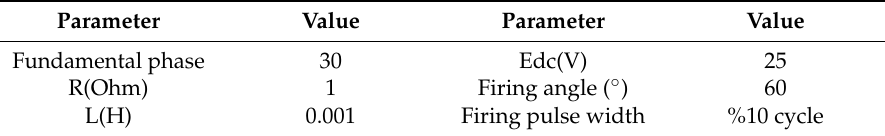
Table 1. Fixed experimental parameters involved in the simulations.